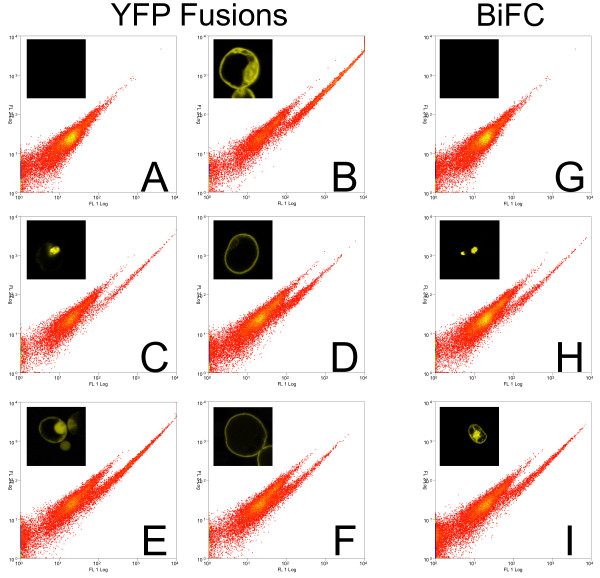
Detection sensitivity of YFP fusion proteins. We tested our cytometer for its detection sensitivity of different protein fusions. One can see from comparison with the mock negative control, that YFP expressing protoplasts can be clearly identified as a cloud of cells shifted to the right in the FL1 channel. A. Mock transfected (water only), B.CPK3-mYFPC.ARR2-mYFPD.FLS2-mYFPE.free mYFPF.SLAC1-mYFPG. Mock transfected (water only), H.bZIP63-YN + bZIP63-YC[6], I.T14-3c-YN + T14-3c-YC[6].